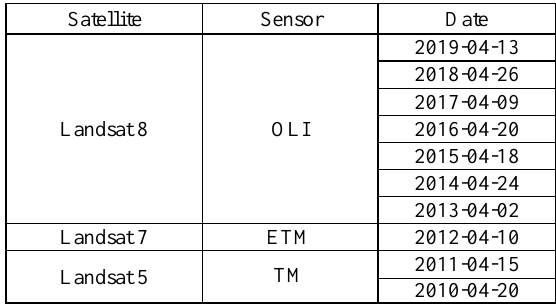
Table 1. List of Landsat Images to extract changes